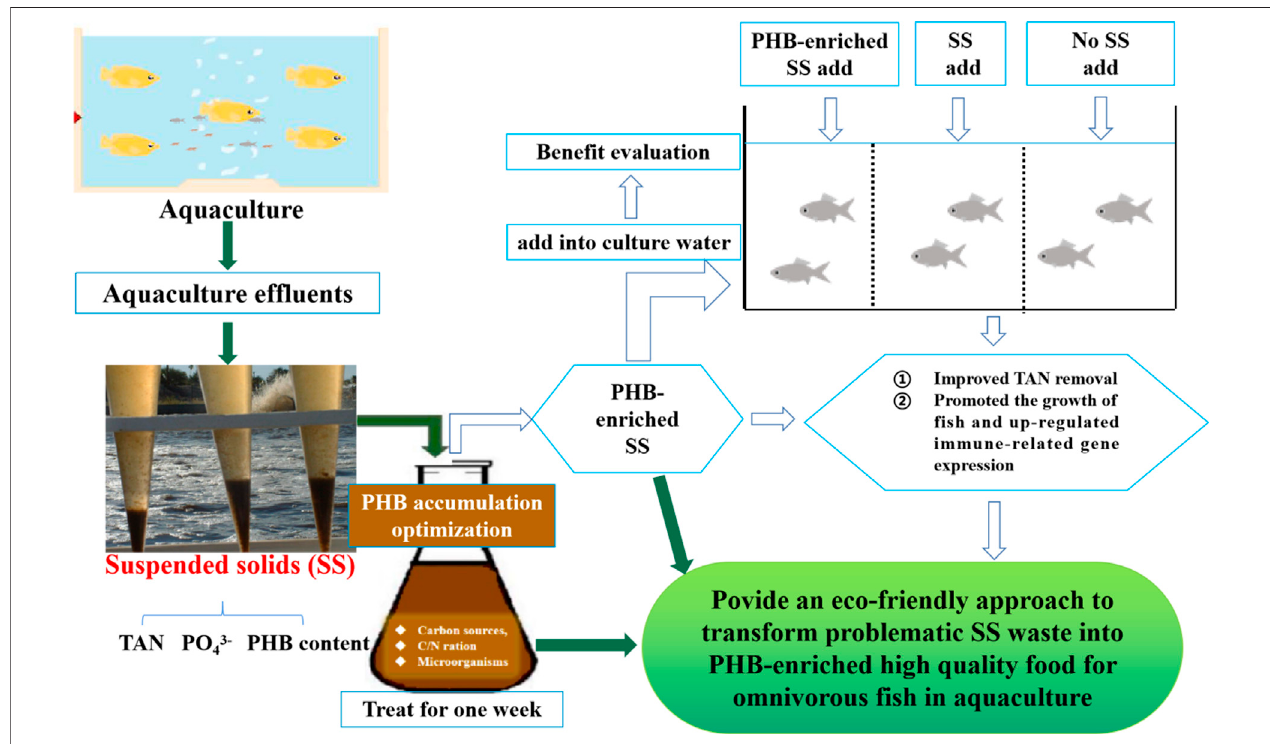
FIGURE 1 | Graphical representation of the aquaculture suspended solid (SS) treatment process by adding carbons considering PHB accumulation.